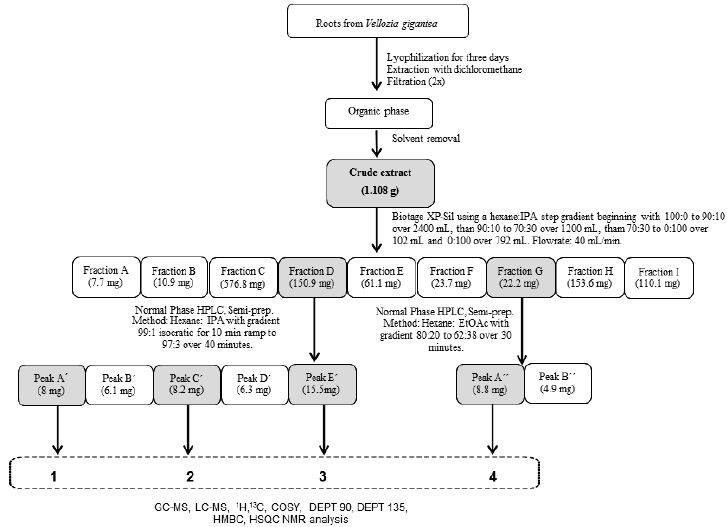
Figure 1. Flowchart illustrating the process of chemical isolation of four phytotoxic compounds produced by Vellozia gigantea , which was guided by phytotoxicity bioassays. All bioactive fractions and compounds are shaded.